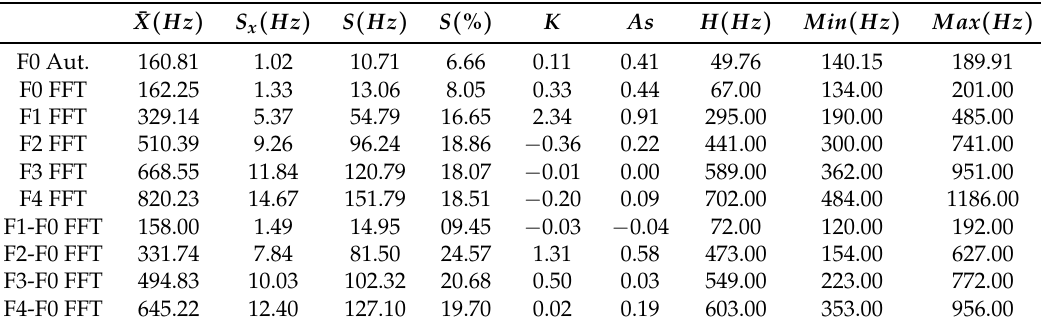
Table A7. Statistical descriptive measures of data without outliers by frequency measurement of the standard group of C. capitata .